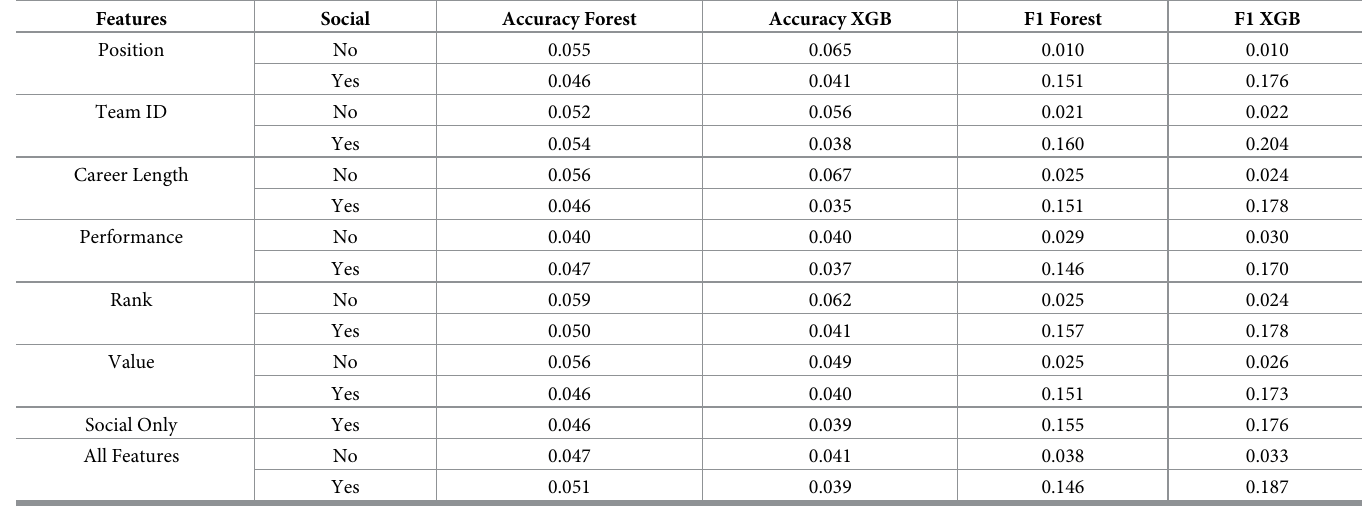
Table 8. Baseball prediction results: The prediction accuracy and F1 score is shown for team transition in MLB during 2020 season for players who had Twitter accounts. Each row indicates which feature(s) were used.